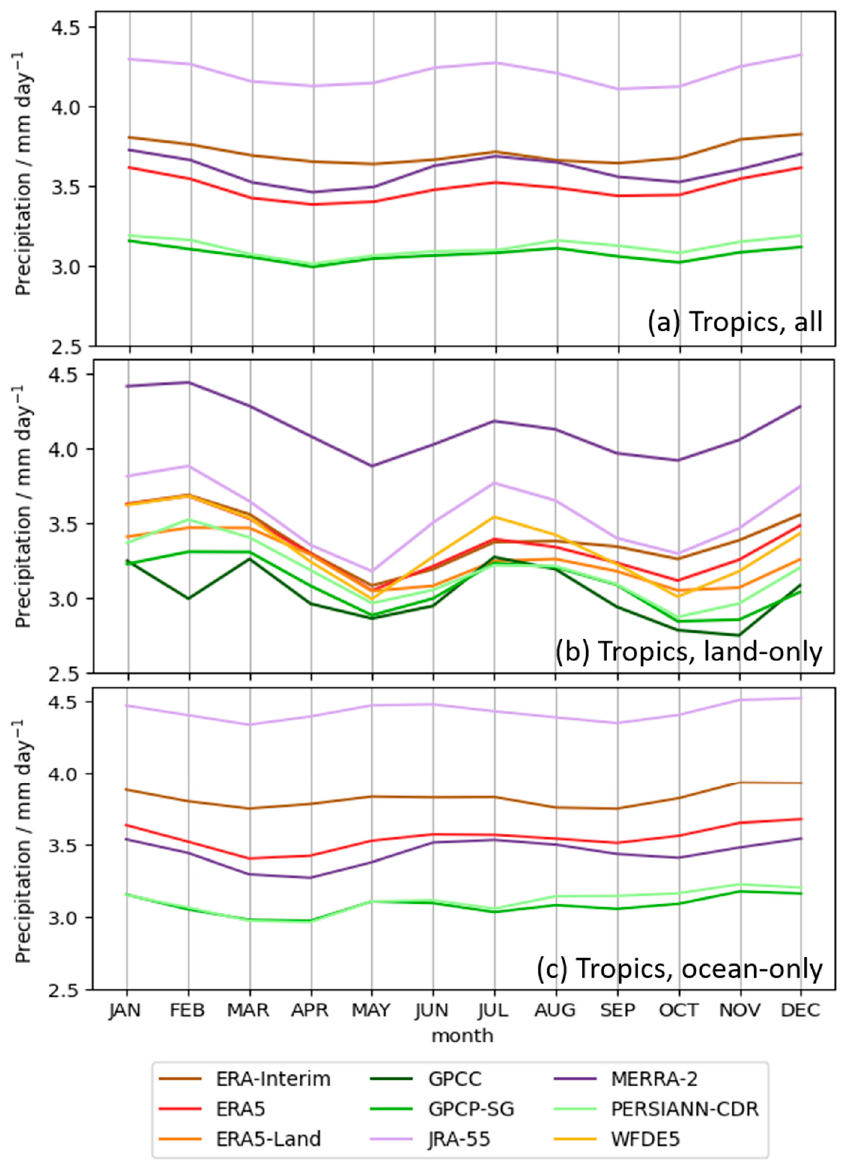
Figure 10. Annual cycle of precipitation rates for the Tropics calculated over the period 1983–2016. ( a ) entire Tropics; ( b ) land ‐ only values (including ERA5 ‐ Land, GPCC and WFDE5 data); ( c ) ocean ‐ ( a ) entire Tropics; ( b ) land-only values (including ERA5-Land, GPCC and WFDE5 data); ( c ) ocean- only values. only